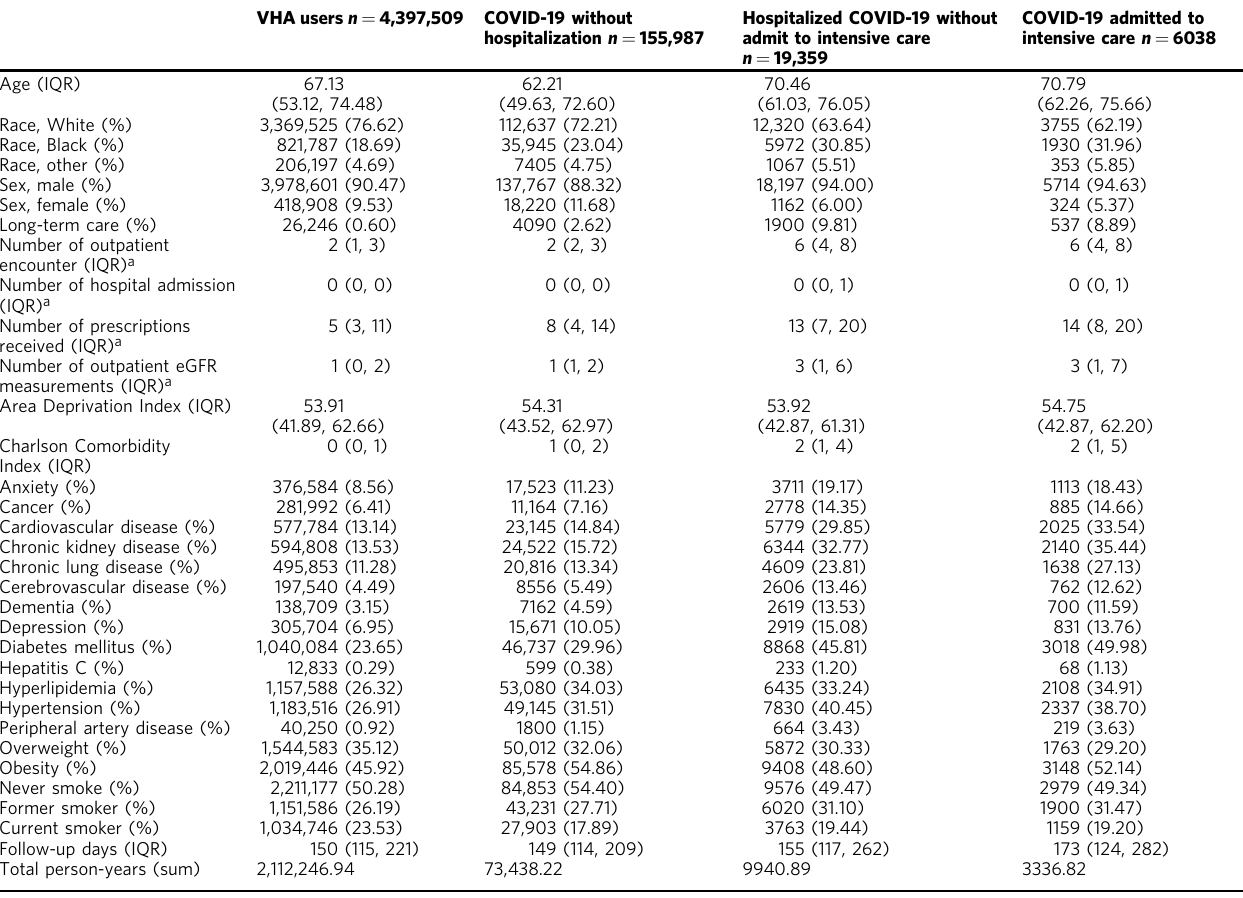
Table 1 Characteristics of (1) users of Veterans Health Administration (VHA), (2) non-hospitalized people with COVID-19, (3) hospitalized COVID-19 but not admitted to intensive care, and (4) hospitalized COVID-19 admitted to intensive